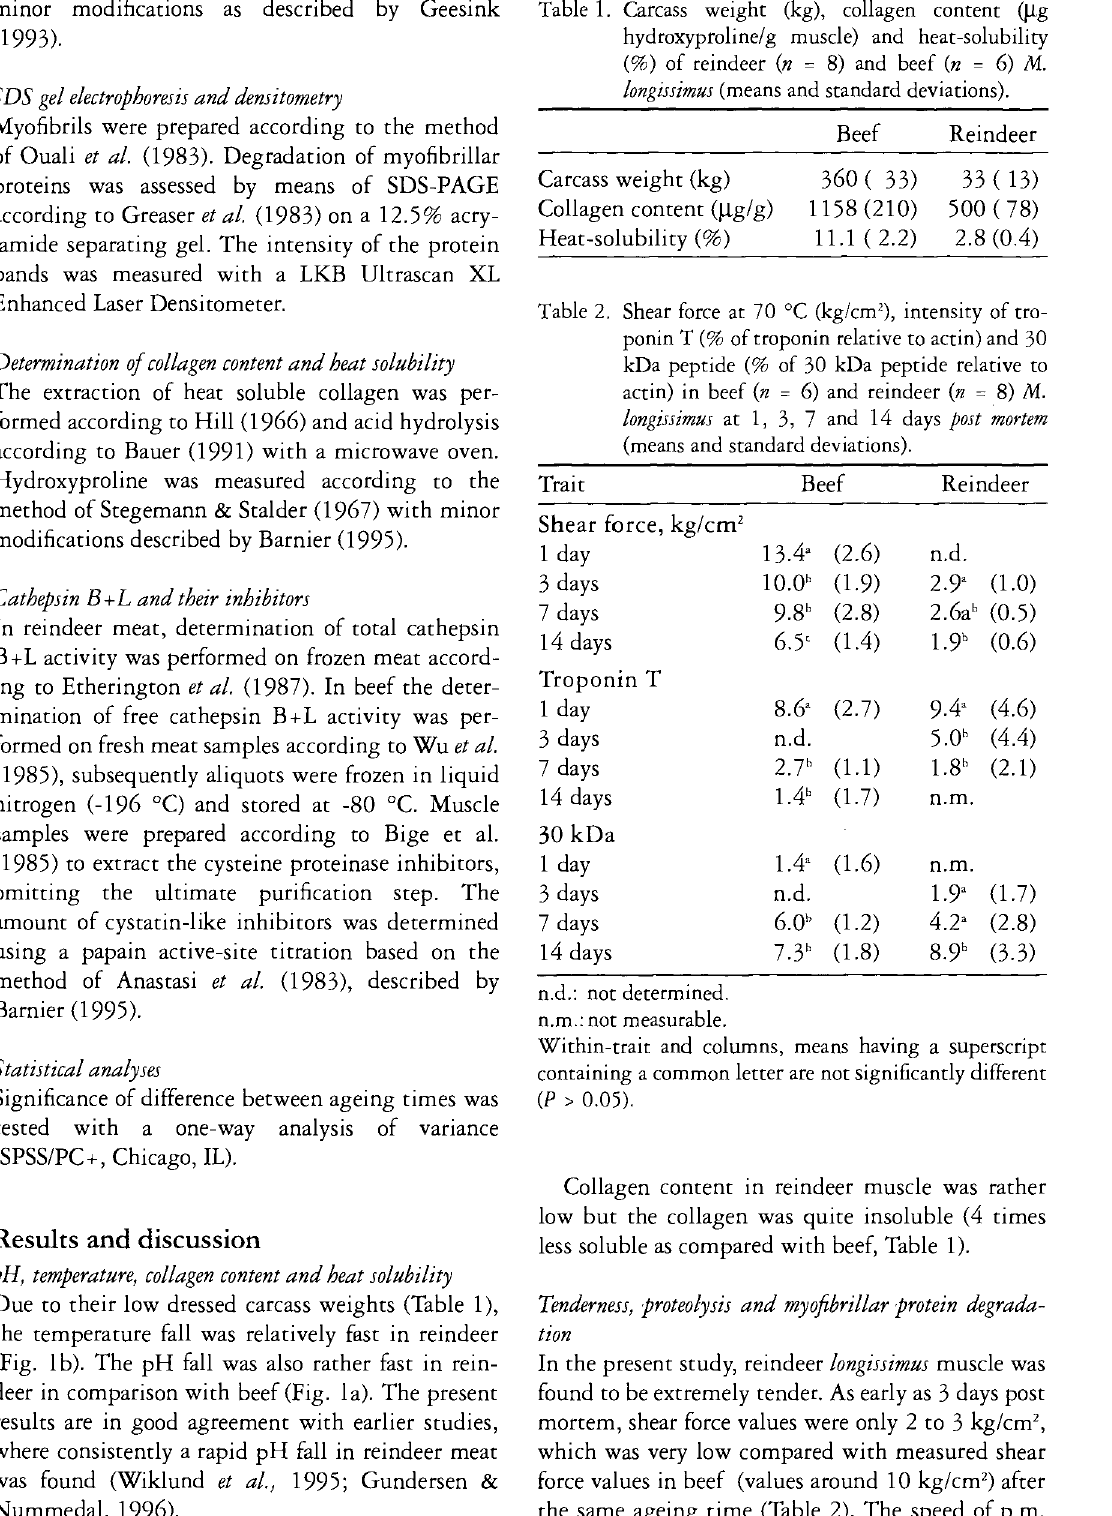
Table 1. Carcass weight (kg), collagen content (|J,g hydroxyproline/g muscle) and heat-solubility (%) of reindeer (n = 8) and beef (n - 6) M.